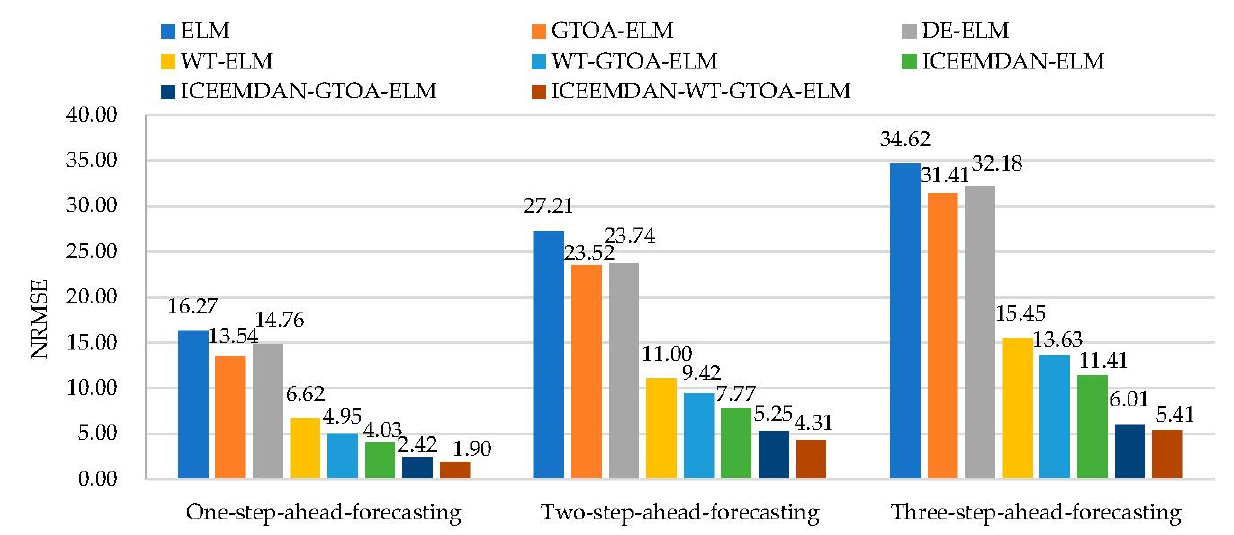
Figure 10. MAE of PM2.5 forecasting. Table 4. Forecasting error of PM2.5 concentration.